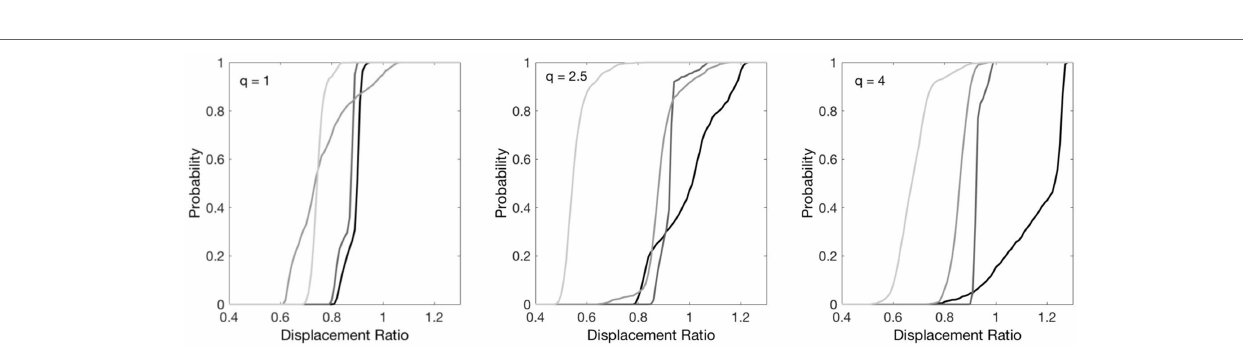
FigUre 8 | Tornado plots resulting from the sensitivity analysis: (a) displacement sensitivity and (B) sensitivity of the tension in the hoist cable. The displacement and cable tension values for the reference case are 80, 90, and 97 mm (a) and 10.4, 7.5, and 6.7 kN (B) ,